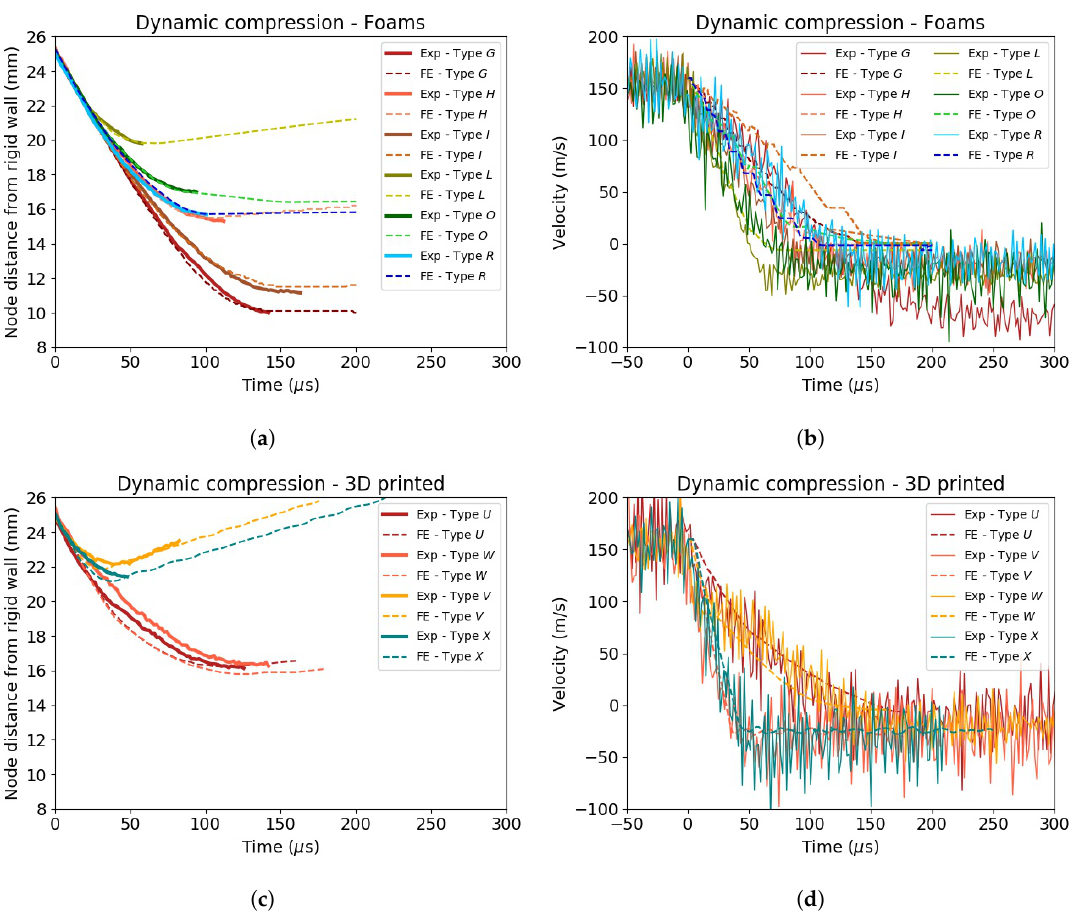
Figure 16. Comparison between experimental and FE results for foams and 3D printed specimens.